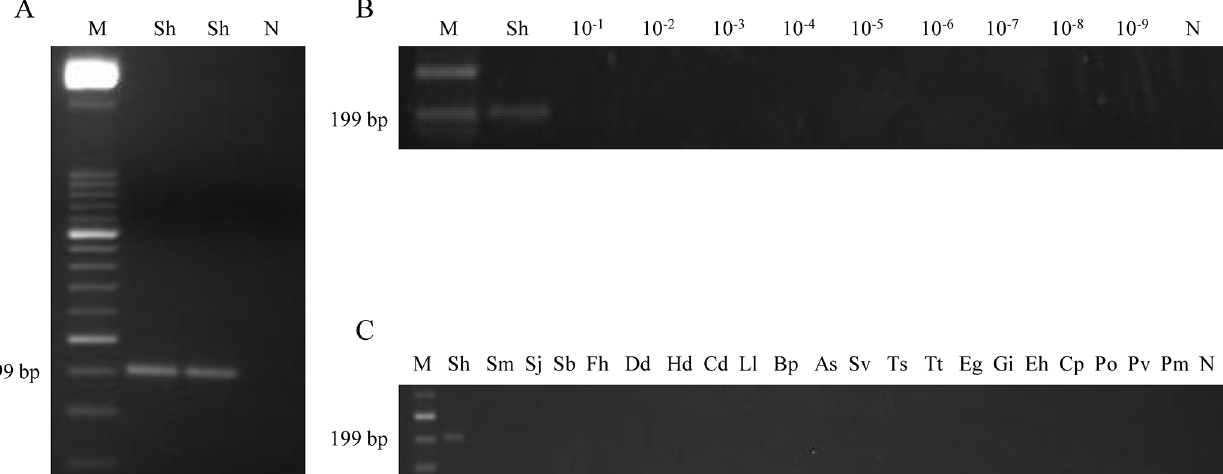
Fig 2. PCR verification, detection limit and specificity using outer primers F3 and B3. (A) PCR verification of expected 199 bp target length amplicon. Lane M, 50 bp DNA ladder (Molecular weight marker XIII, Roche); lane Sh, S . haematobium DNA (1 ng); lane N, negative control (no DNA template). (B) Detection limit of PCR. Lane M, 50 bp DNA ladder (Molecular weight marker XIII, Roche); lane Sh: S . haematobium DNA (1 ng); lanes 10 − 1 – 10 − 9 : 10-fold serially dilutions of S . haematobium DNA; lane N, negative control (no DNA template). (C) Specificity of PCR. Lane M, 50 bp DNA ladder (Molecular weight marker XIII,